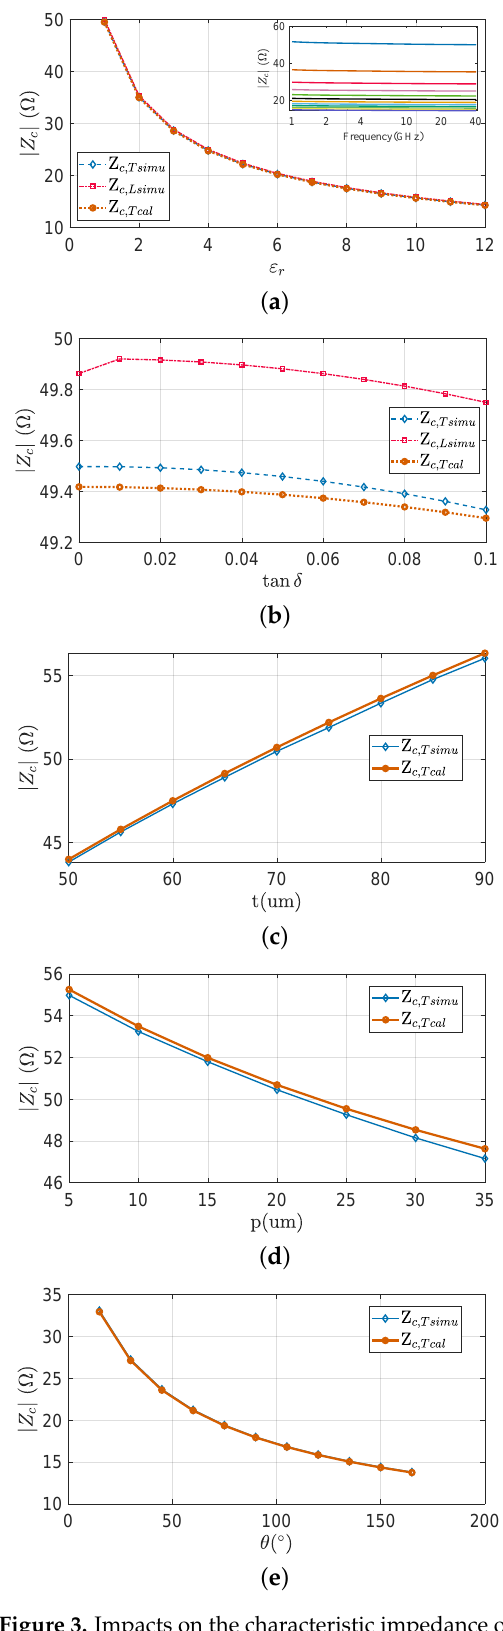
Figure 3. Impacts on the characteristic impedance of the ( a ) dielectric constant and ( b ) dielectric loss tangent values of the single substrate, ( c ) thickness of a BCB ring inserted in a Si substrate, ( d ) position of a BCB ring in a Si substrate, and ( e ) angle of a fan-shaped air area in a Si